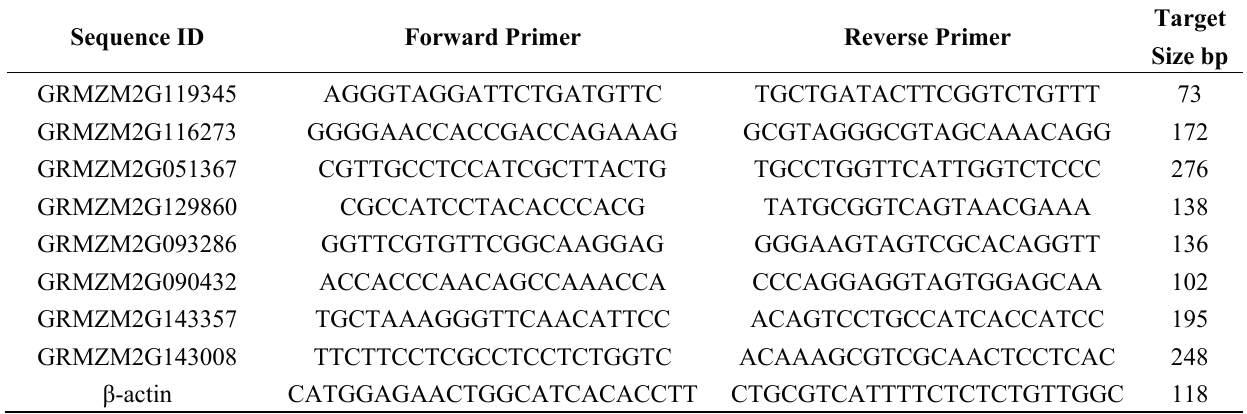
Table 2. List of primers used for the Real-time